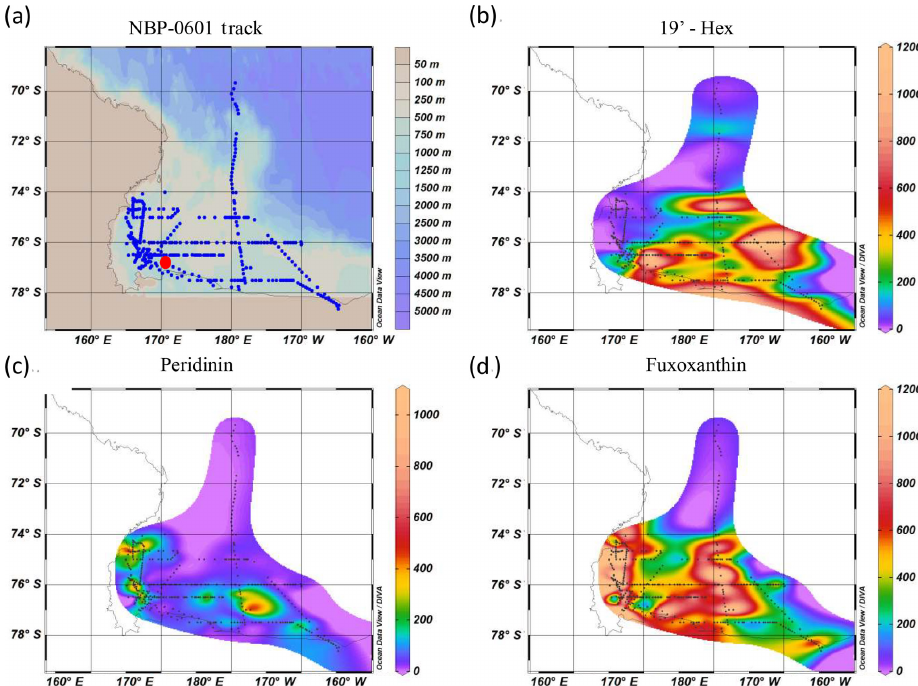
Figure 8. Location of the metaproteome sample and pigment data from a Ross Sea Phaeocystis bloom net tow sample. (a) Station map of NBP06-01 (27 December 2005 to 23 January 2006); the metaproteome sample was taken on 30 December by net tow location (red circle). (b) 19’-hexanoyloxyfucoxanthin (“19’-Hex”) pigment is associated with Phaeocystis , while (c) peridinin and (d) fucoxanthin pigments are typically associated with dinoflagellates and diatoms, respectively (although dinoflagellates living heterotrophically can be lacking in pigment). Comparisons of the spring and summer expeditions (NBP06-08 and NBP06-01, respectively) revealed a shift from being dominated by P. antarctica to being a mixture of P. antarctica and diatoms. See Smith et al. (2013) for further